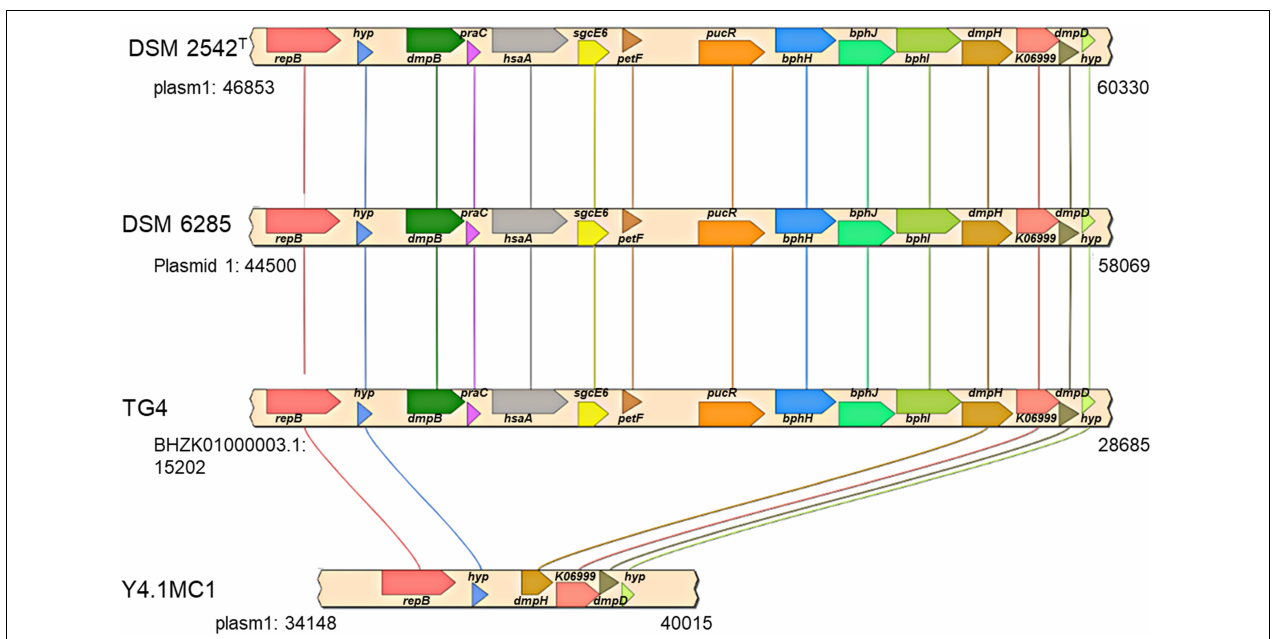
FIGURE 6 | Organization of a plasmid phenol degradation locus (HSUL 2) harboring a ferredoxin (petF) gene unique to hydrogen producing P. thermoglucosidasius strains. repB, dmpB, praC, hsaA, sgcE6, petF, pucR, bphH, bphJ, bphI, dmpH, K06999, dmpD and hyp , which code for initiator replication protein, catechol 2,3-dioxygenase, 4-oxalocrotonate tautomerase, 3-hydroxy-9,10-secoandrosta-1,3,5(10)-triene-9,17-dione monooxygenase, flavin reductase, ferredoxin, purine catabolism regulatory protein, 2-oxopent-4-enoate hydratase, acetaldehyde/propanal dehydrogenase, 4-hydroxy-2-oxovalerate/4-hydroxy-2-oxohexanoate aldolase, 2-oxo-3-hexenedioate decarboxylase, phospholipase/carboxylesterase, 2-hydroxymuconate-semialdehyde hydrolase and proteins of unknown function,